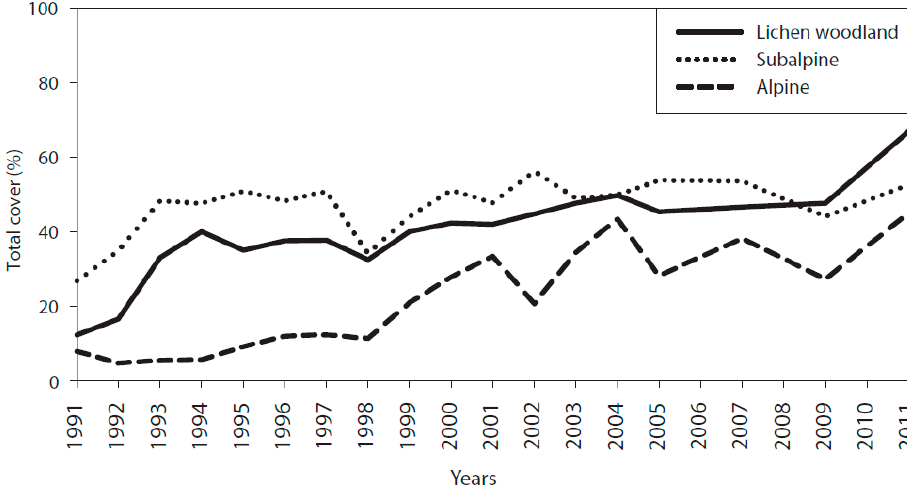
Figure 2. Vegetation cover in the lichen woodland, subalpine and alpine sites along the postfire chronosequence (extrapolated data in 2006, 2008 and 2010), Parc des Grands-Jardins, southern Quebec (Canada).